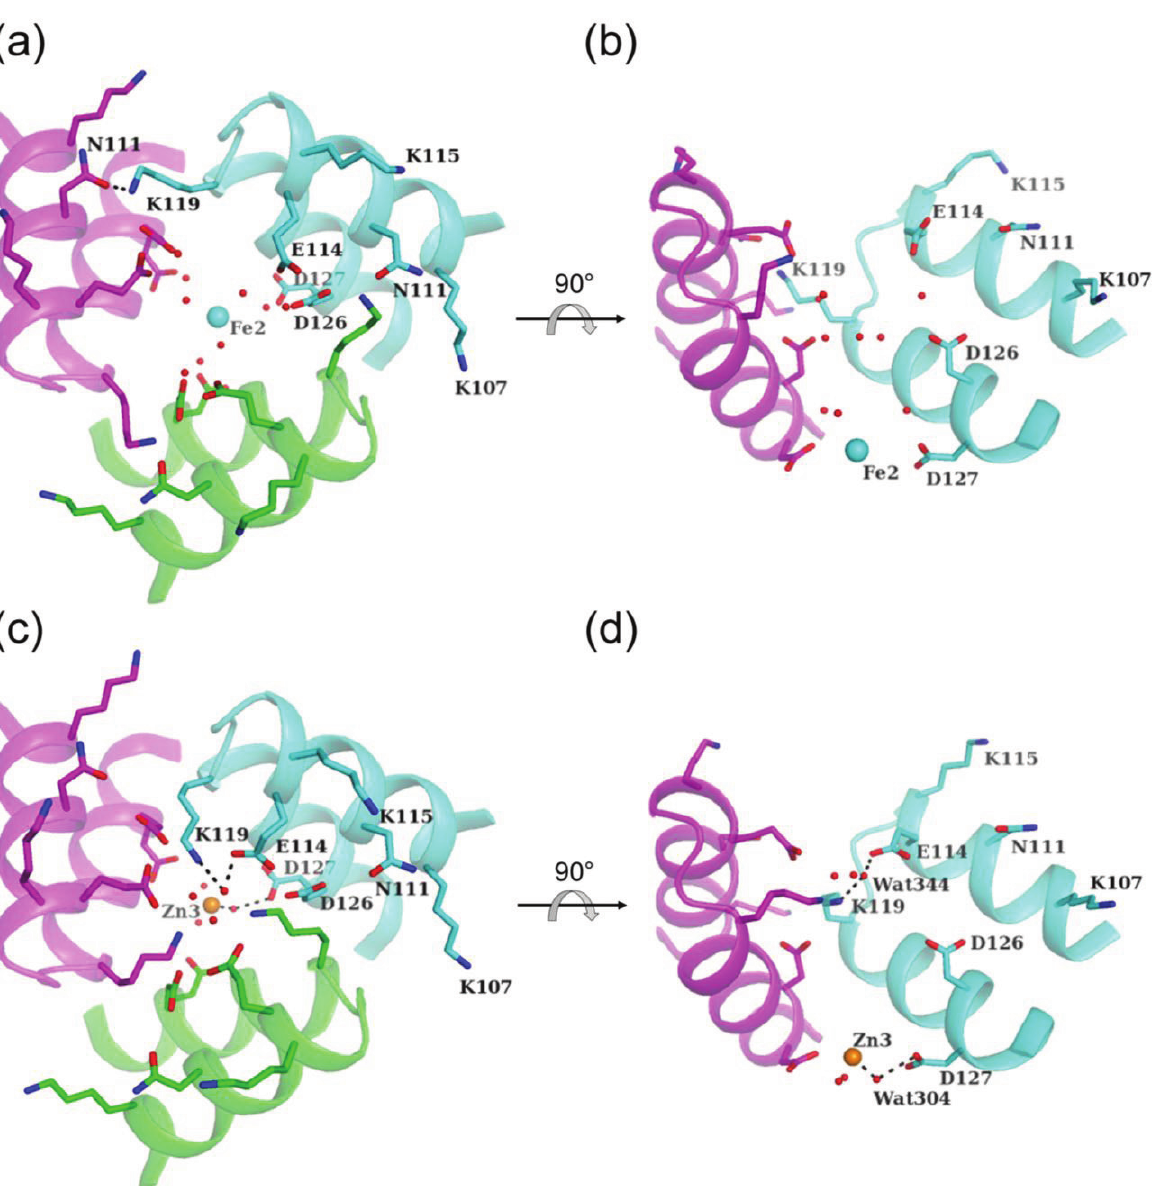
Figure 6. Pore I along the three-fold axis. Three-fold-axis-related trimers (cyan, magenta, and green) in Fe-loaded HP-NAP YS39 ( a , b ) and Zn-loaded HP-NAP YS39 ( c , d ). Iron, zinc, and water molecules are shown as cyan, orange, and red spheres, respectively. The key residues forming pore I are shown in sticks. Dashed lines indicate coordinate bonds or hydrogen bonds. Fe2 indicates the second iron ion of Fe-loaded HP-NAP YS39. Zn3 indicates the third zinc ion of Zn-loaded HP-NAP YS39. The view is from outside of the spherical shell ( a , c ) and is from the side ( b , d ). One polypeptide chain (green) is omitted for clarity in ( b , d